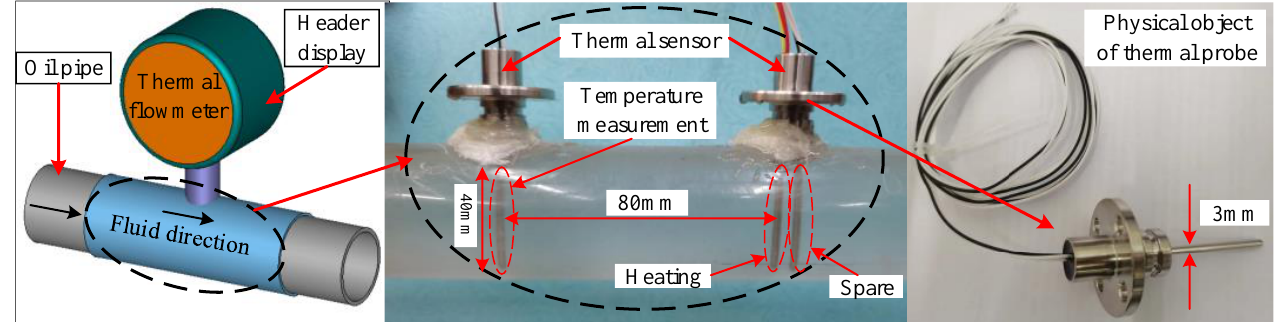
Figure 1. Mechanical structure of thermal flowmeter.